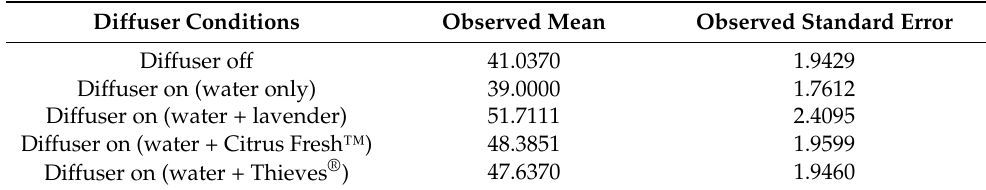
Table 2. Mean and standard error for each set of experimental conditions run on lodgepole pine pollen.